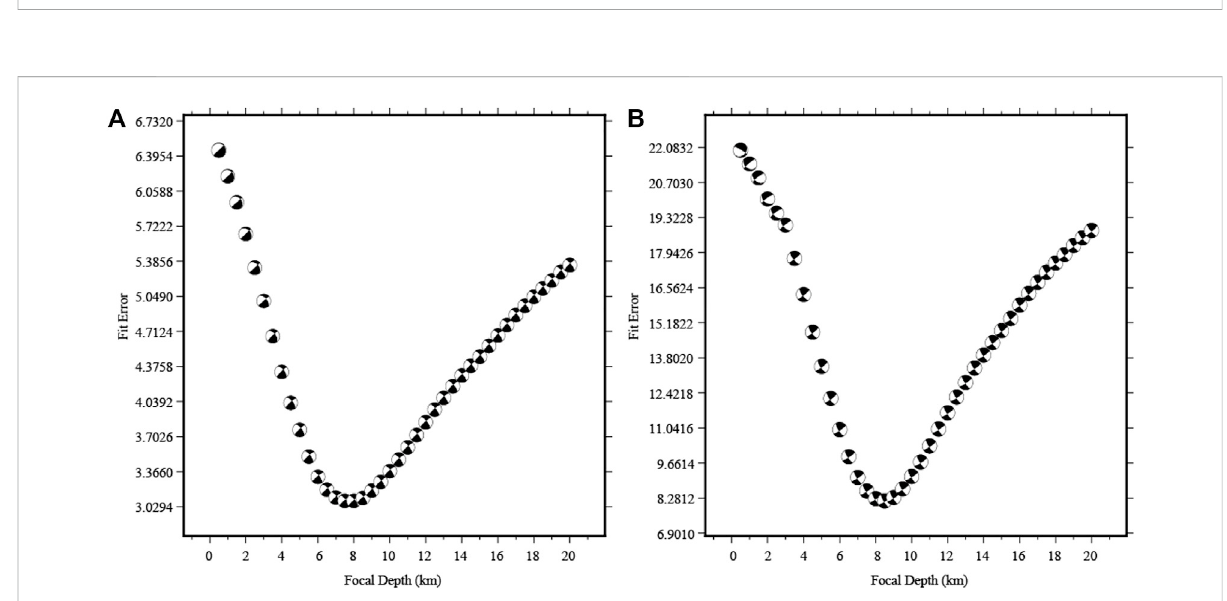
FIGURE 9 Variations in RMS error with focal depth during the focal mechanism inversion for the (A) M s5.8 and (B) M s6.0 Maerkang